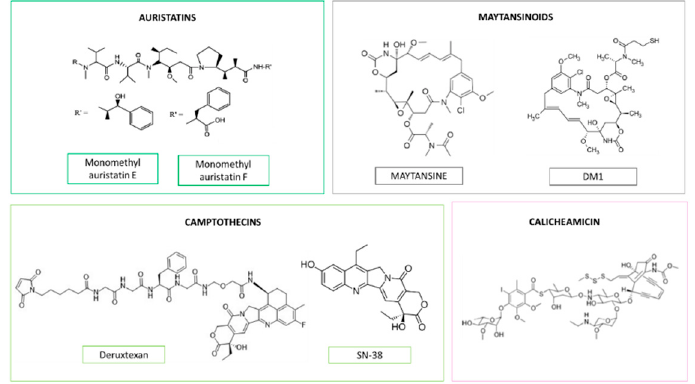
Figure 5. Chemical structure of most common drugs used in antibody–antineoplastic conjugates.